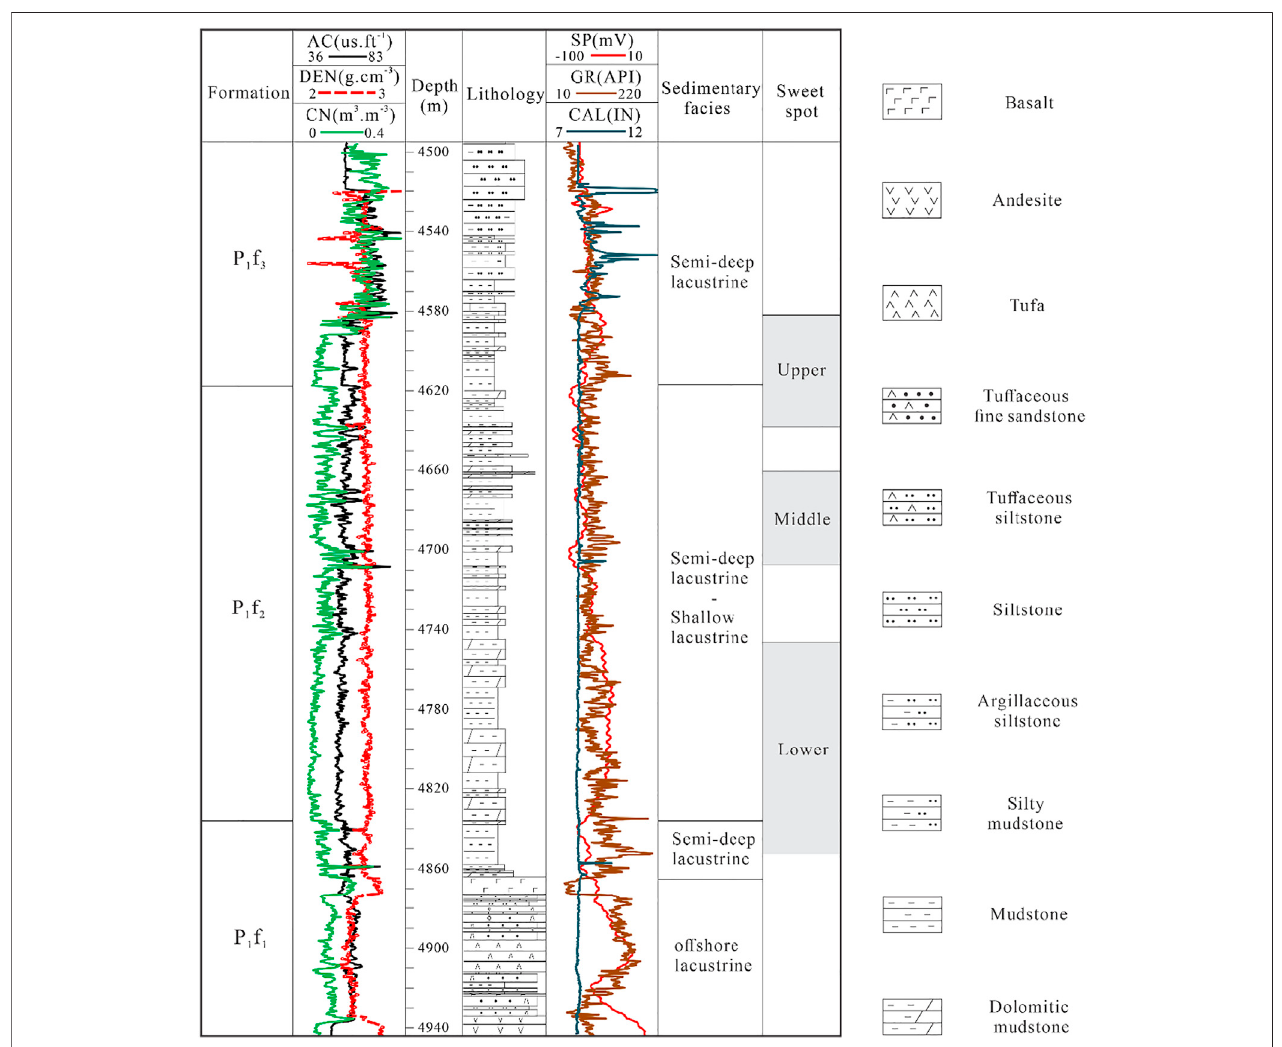
FIGURE 2 | Generalized stratigraphic column of Fengcheng Formation in the Mahu Sag (Tang et al., 2021).